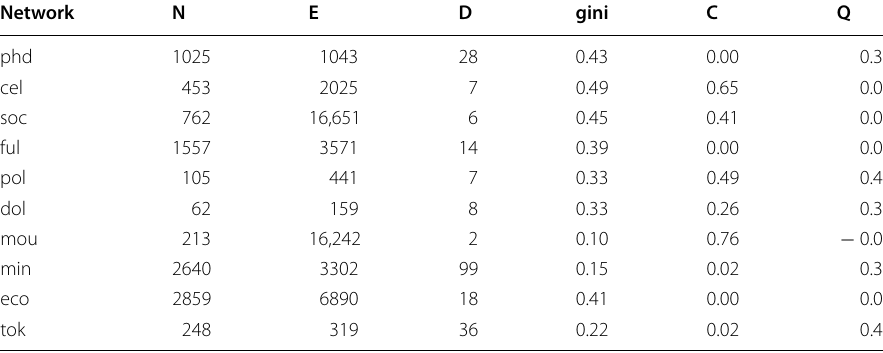
Columns contain: N: number of nodes, E: number of edges, D: network diameter, gini: GINI coefficient of the degree distribution, C: clustering coefficient, Q: